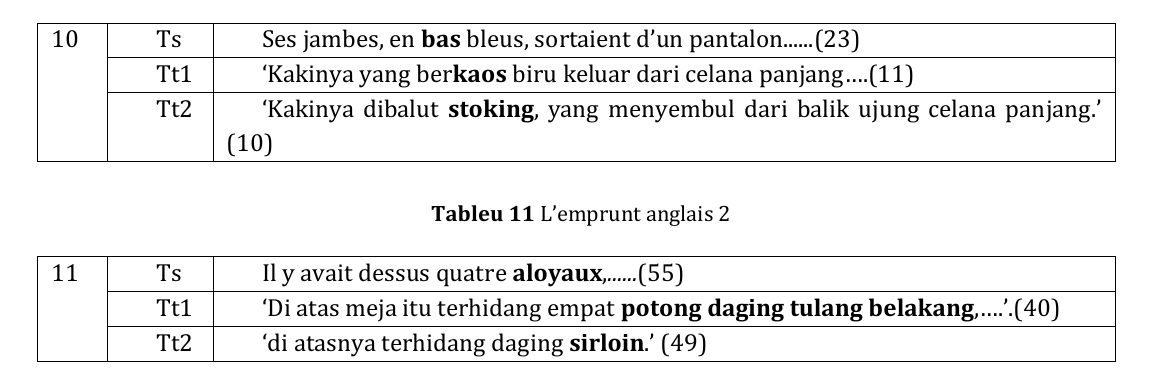
Tableu 10 L’emprunt anglais 1